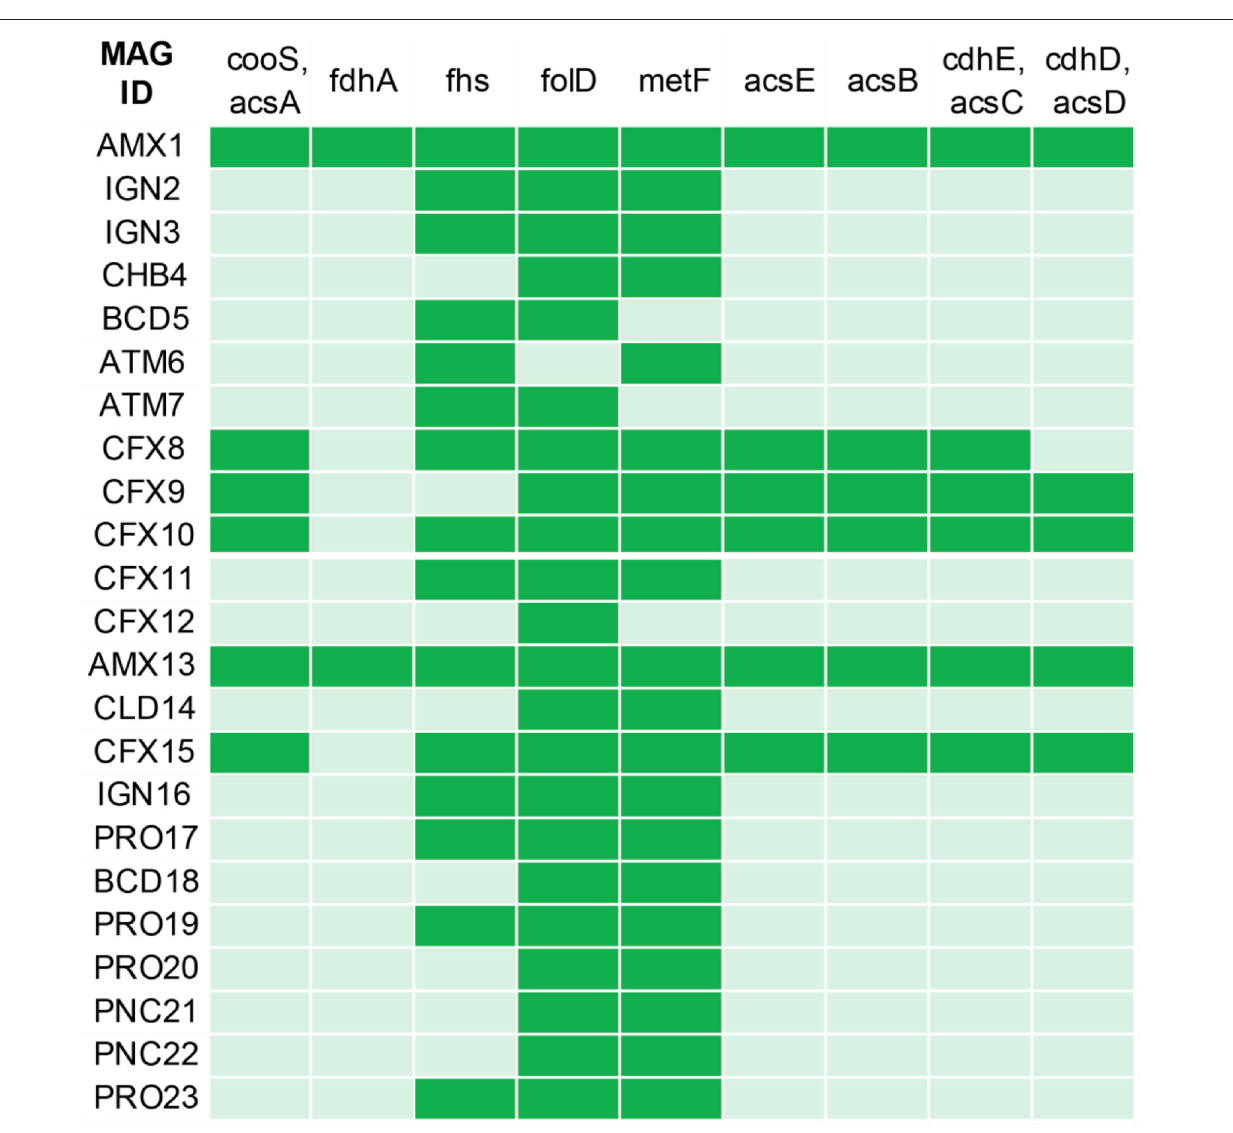
FIGURE 4 | Marker genes involved in the biochemical CO 2 fixation pathway (Wood–Ljungdahl pathway) predicted across the recovered MAGs annotated by KOALA (KEGG Orthology And Links Annotation). The genes encoding key enzymes involved in Wood–Ljungdahl pathway: anaerobic carbon-monoxide dehydrogenase catalytic subunit (cooS, acsA); formate dehydrogenase (NADP + ) alpha subunit (fdhA); formate–tetrahydrofolate ligase (fhs); methylenetetrahydrofolate dehydrogenase (NADP + )/methenyltetrahydrofolate cyclohydrolase (folD); methylenetetrahydrofolate reductase (NADPH) (metF, MTHFR); 5-methyltetrahydrofolate corrinoid/iron sulfur protein methyltransferase (acsE); acetyl-CoA synthase (acsB); acetyl-CoA decarbonylase/synthase, CODH/ACS complex subunit gamma (cdhE, acsC); acetyl-CoA decarbonylase/synthase, CODH/ACS complex subunit delta (cdhD, acsD). Green indicates the presence and light green indicate the absence of the marker